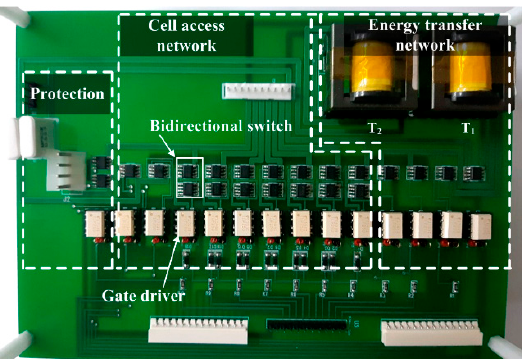
Figure 7. Prototype of the proposed balancing circuit for equalization of six cells.